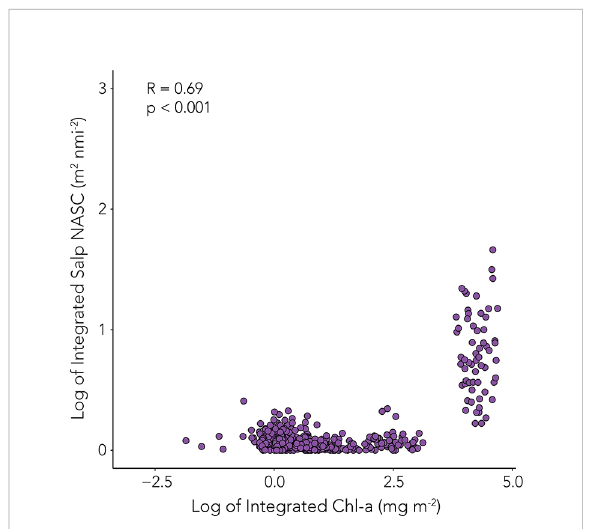
FIGURE 8 Integrated chl- a (mg m -2 ) in 50 m intervals in the top 500 m per pro fi le (from glider upcasts) matched with closest integrated mean NASC (calculated from integrated PRC NASC per downcast pro fi le in 50 m intervals). Only values from glider upcasts and downcasts from the same pro fi le are depicted. Integrated chl- a and mean NASC values were log transformed and Pearson ’ s correlation was performed on the log transformed values to assess signi fi cant correlation. Rho (R) and p-value are